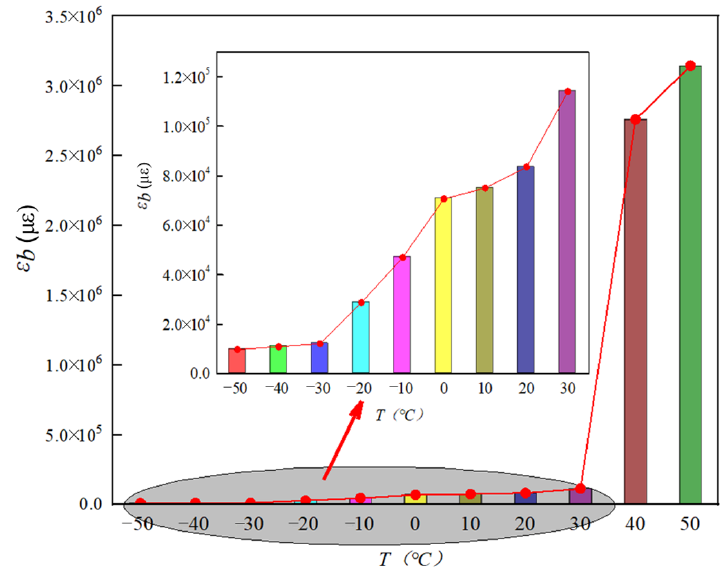
Figure 21. Failure strain of polyurethane cement at different temperature levels.